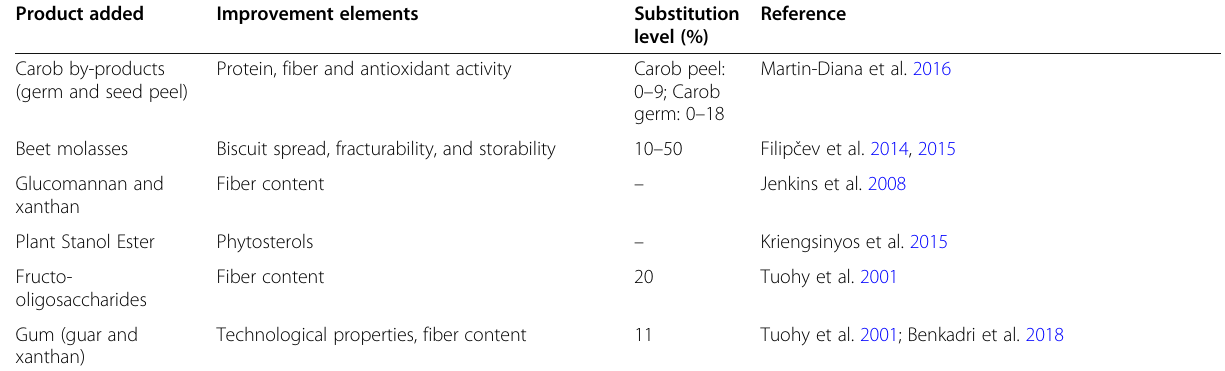
Table 1 Improved materials used to substitute wheat flour in biscuit production (Continued)